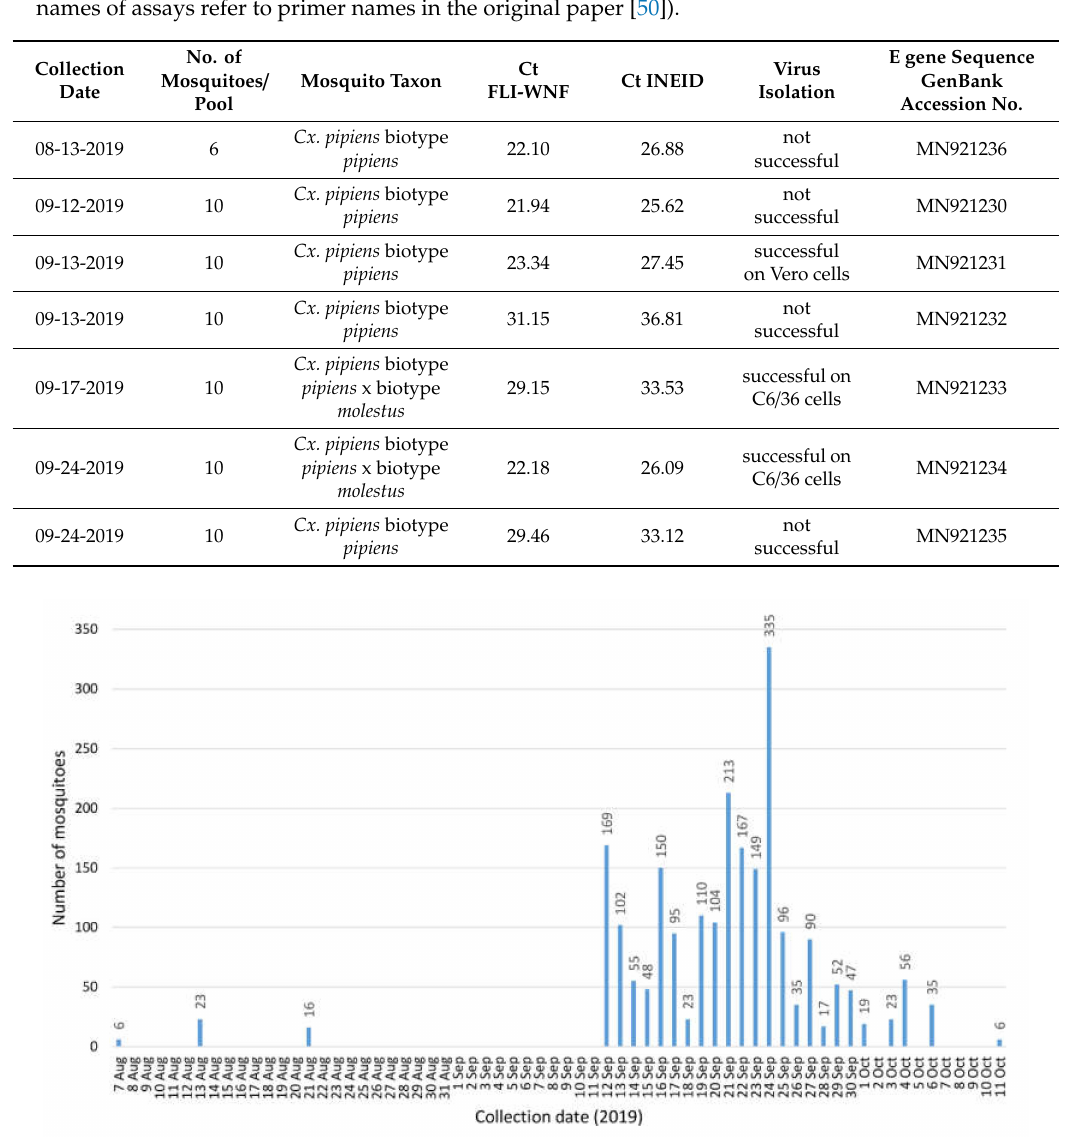
Figure 1. Mosquito numbers collected over time in the Tierpark Berlin in 2019 (26 Jul–9 Sep and 7 Oct–23 Nov: collection by one BG-Sentinel alone; 12 Sep–6 Oct: collection by 20 EVS traps plus one BG-Sentinel; except for 10 and 11 Sep trapping was performed